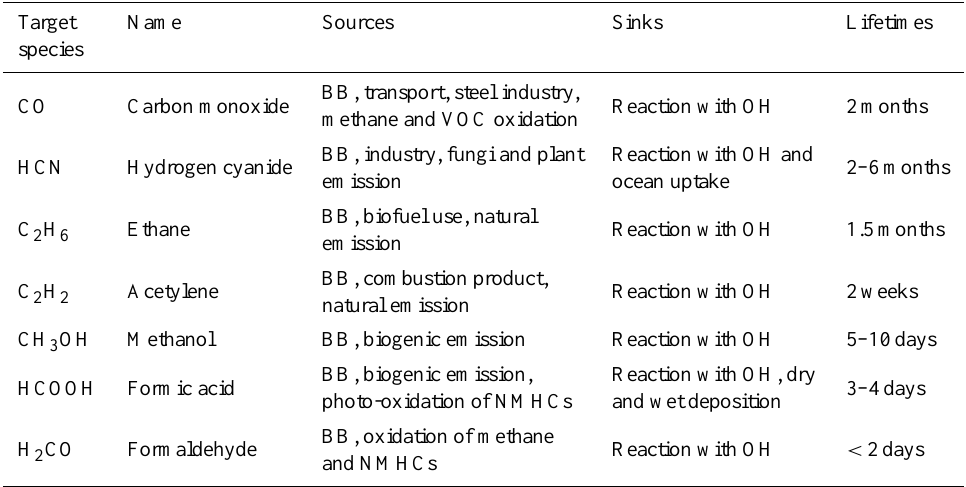
Table 1. Sources, sinks and average lifetimes of all the target species. BB, VOC and NMHCs are the acronyms of biomass burning, volatile organic compound and non-methane hydrocarbons,